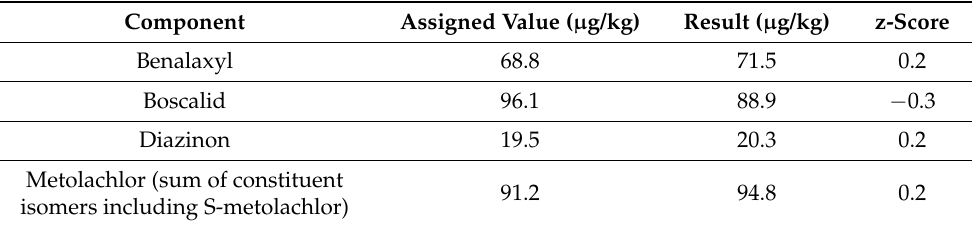
Table 1. Blueberry pur é e, proficiency test 19,258 (FAPAS), October 2018.